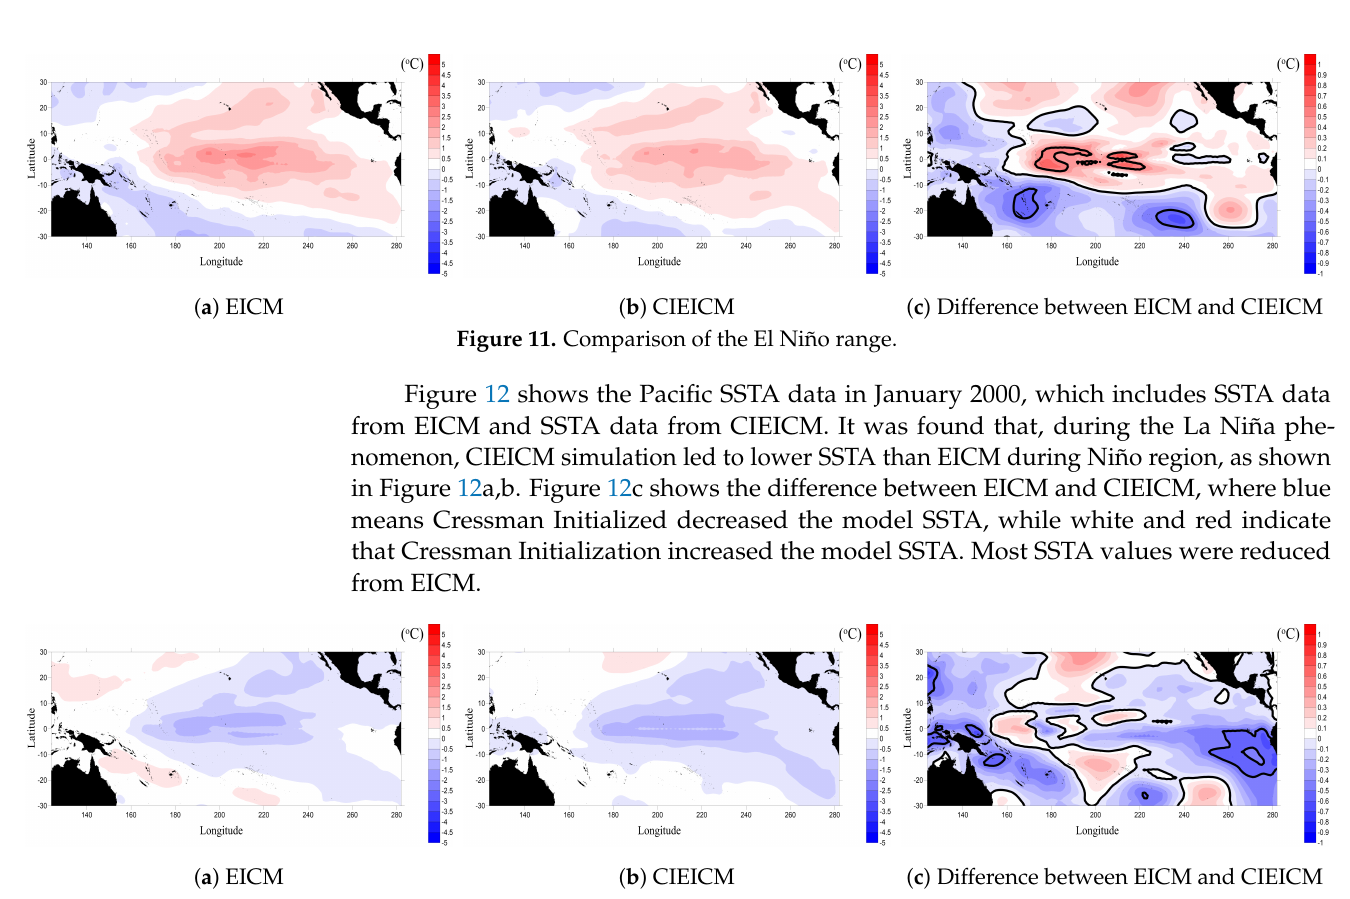
Figure 12. Comparison of the El Niño